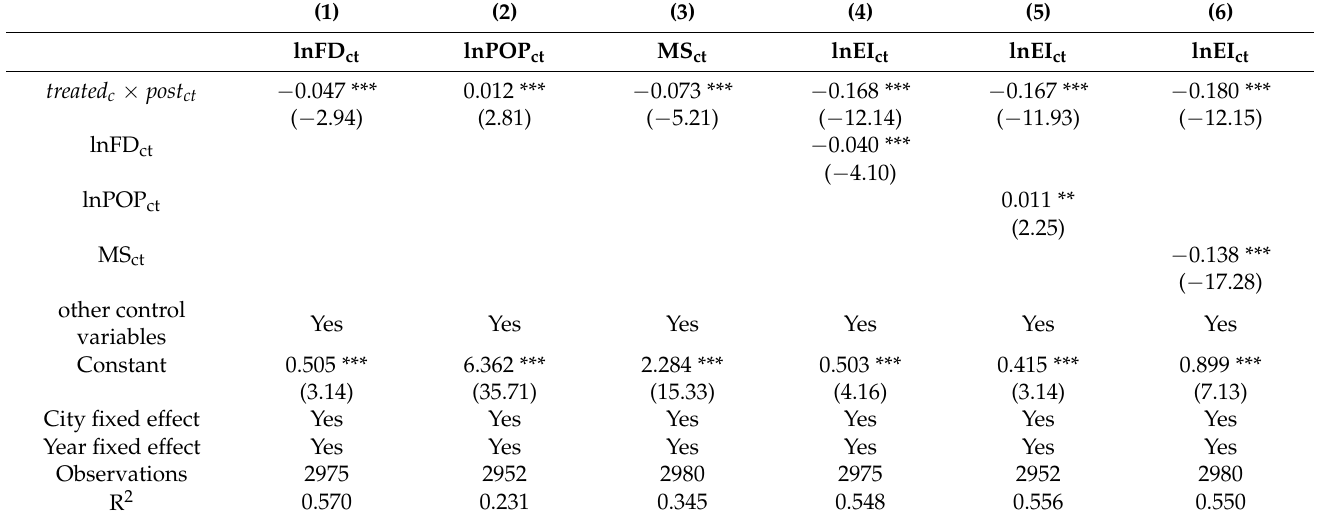
Table 7. Analysis of impact